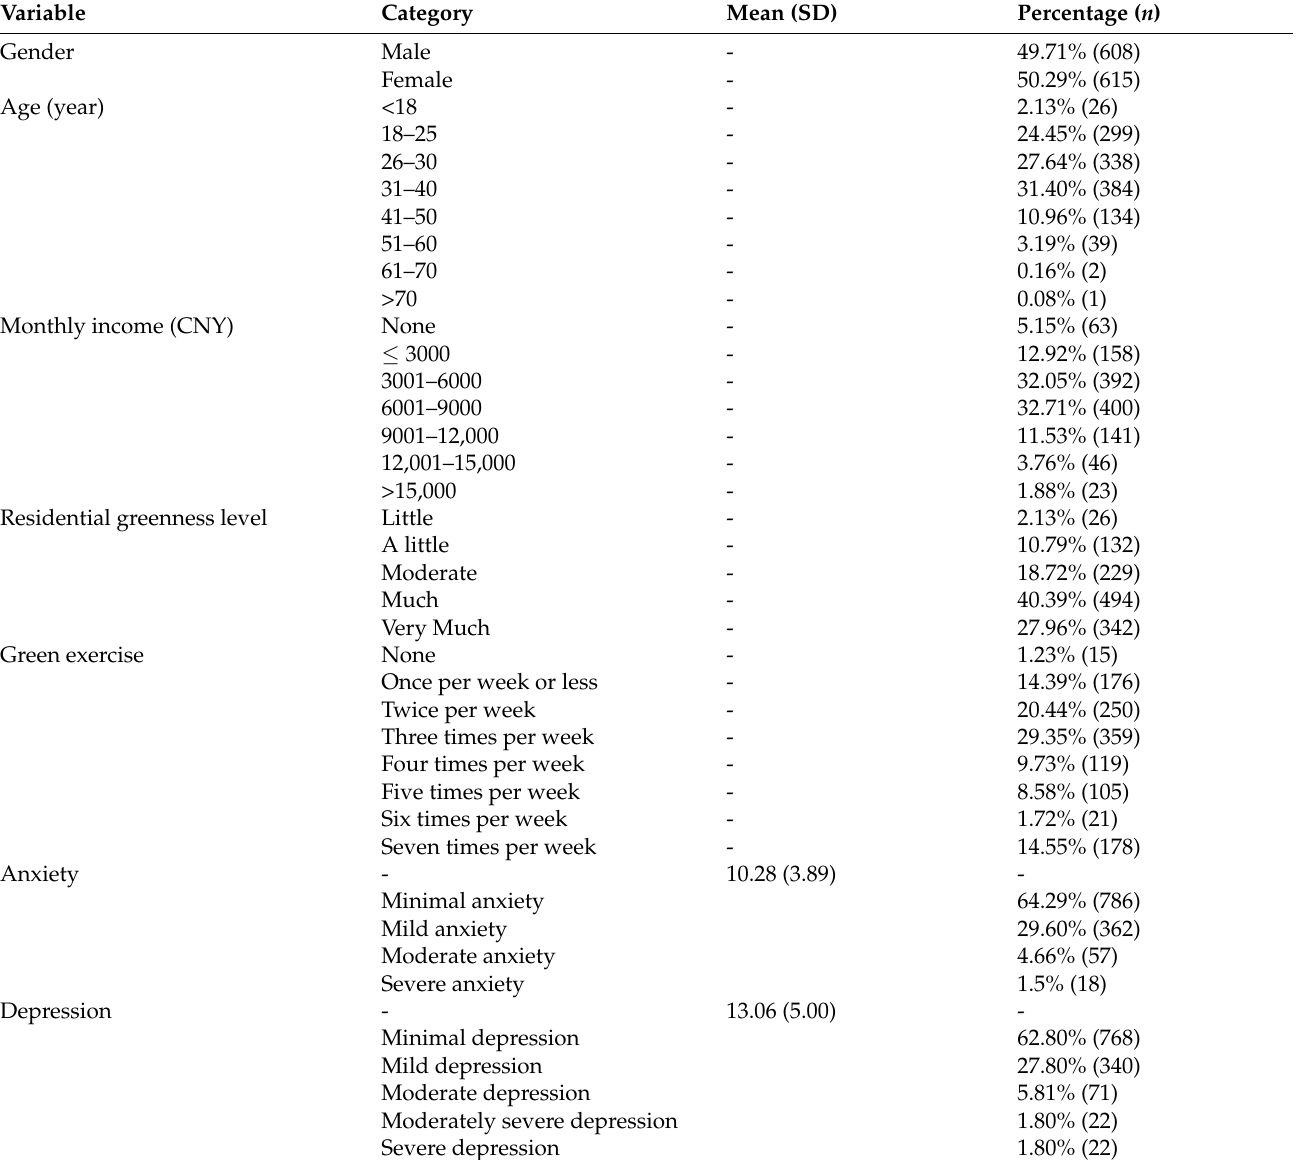
Table 1. Respondent characteristics ( n =